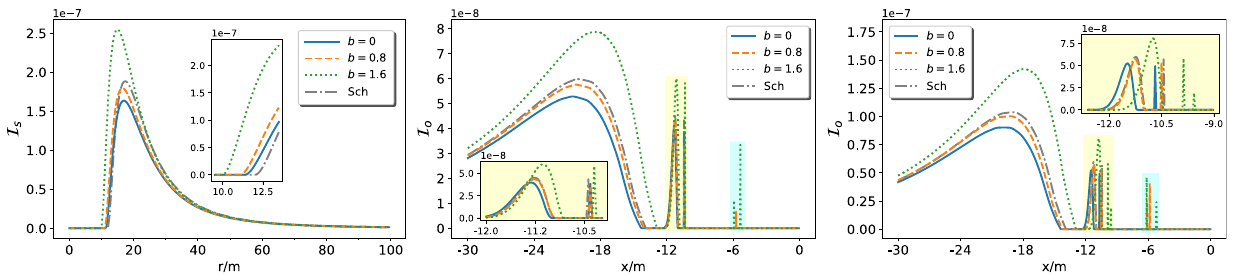
in the disk surface. The middle and the right correspond to the observed intensity I o with inclination angle θ 0 = 30 ◦ and 60 ◦ , respectively